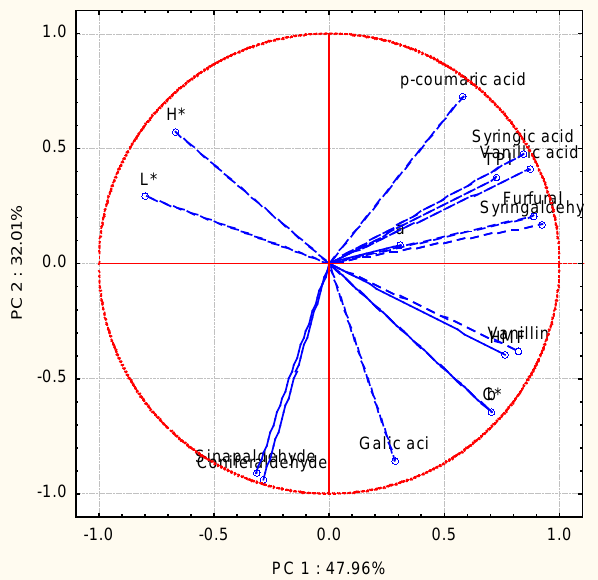
Figure 4. Principal component analysis with distillates of different varieties of grapes aged by an accelerated and traditional method. Projection of the cases on the factor plane.